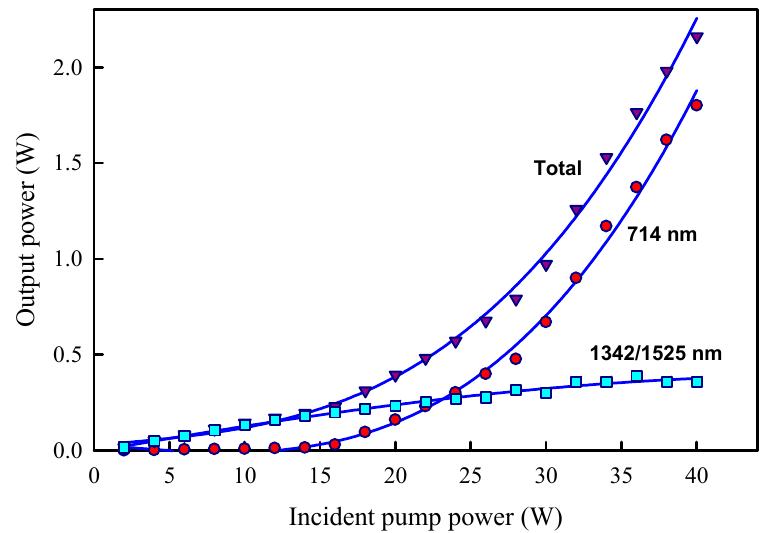
Figure 4. Experimental result for total output power, SFG output power, and fundamental and Raman output powers versus incident pump power with the cavity shown in Figure 1b.